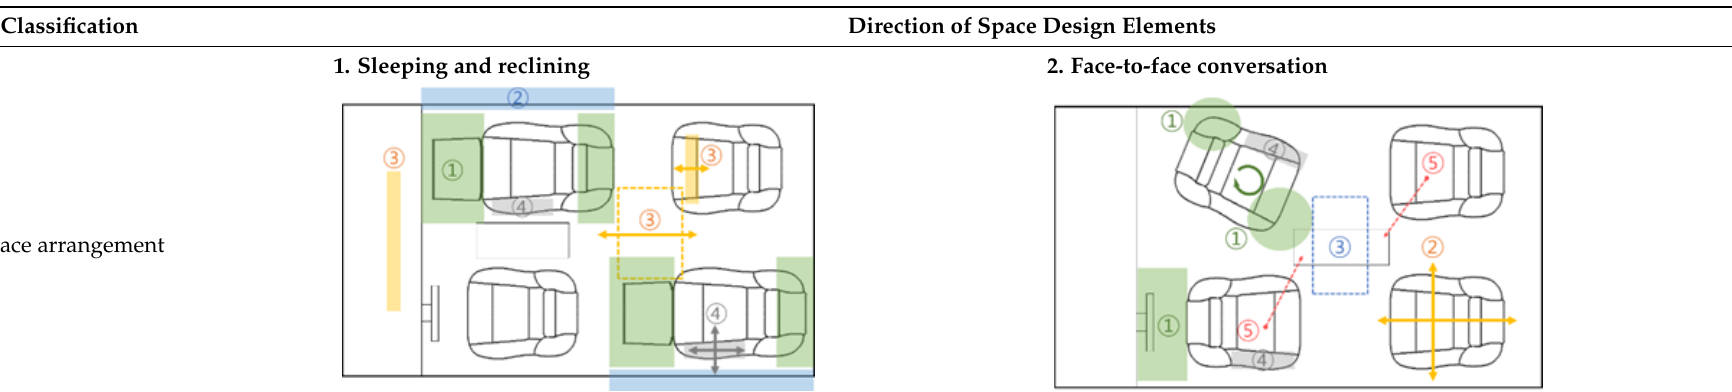
Table 10. Direction of space design elements by in-vehicle activity.